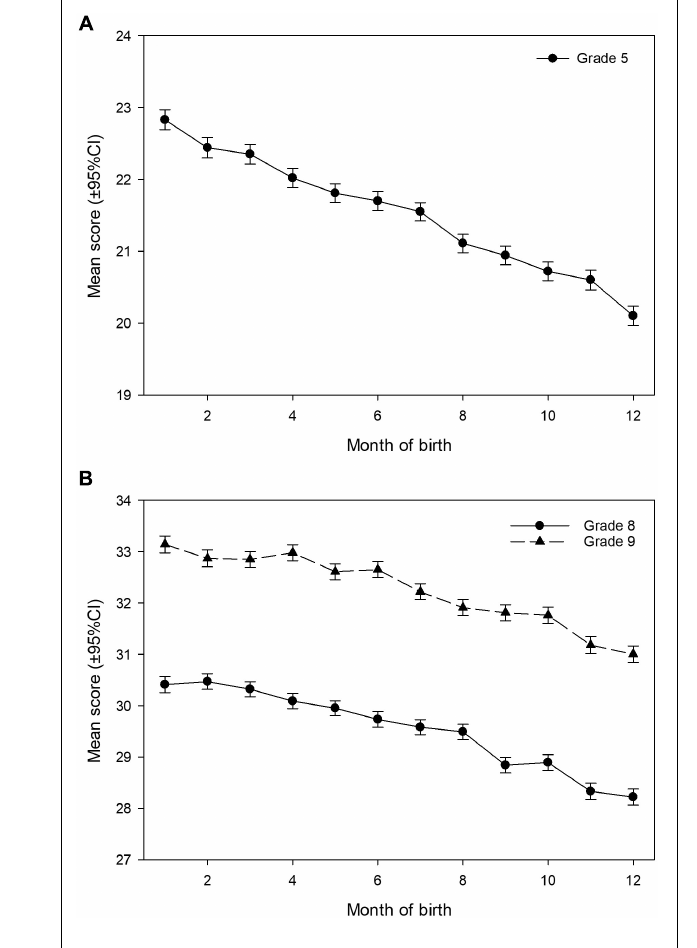
FIGURE 1 | Mean scores in the national reading test for Grades 5 (A) and 8 and 9 (B) relative to month of birth, with 95% Wald confidence intervals.